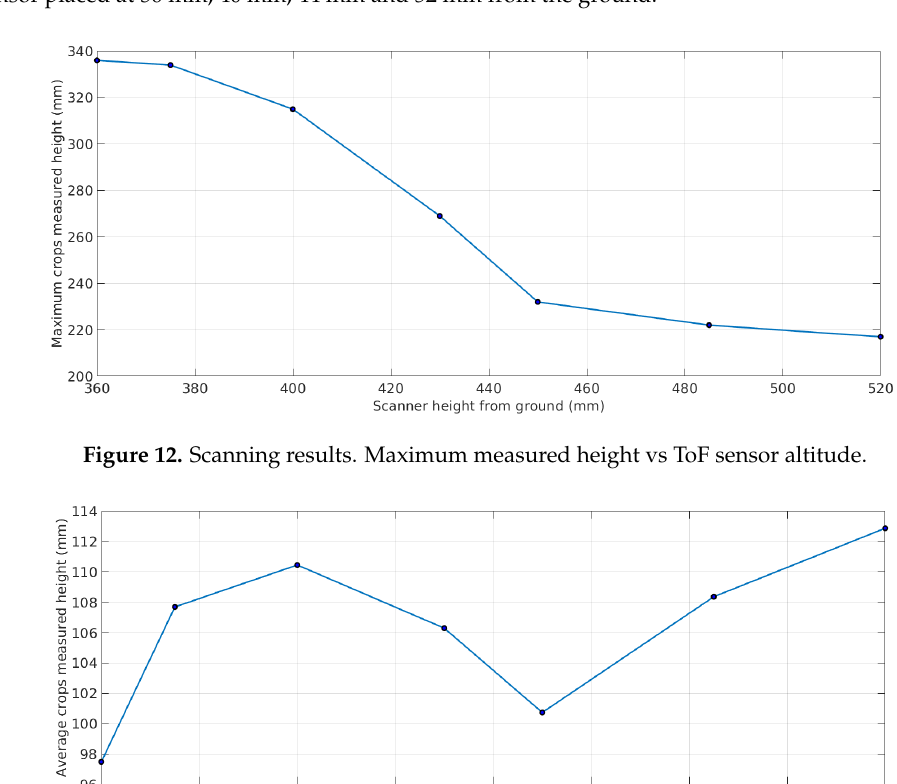
Figure 11. Vegetal coverage mock-up measured at different altitudes. Top to bottom and left to right, sensor placed at 36 mm, 40 mm, 44 mm and 52 mm from the ground.